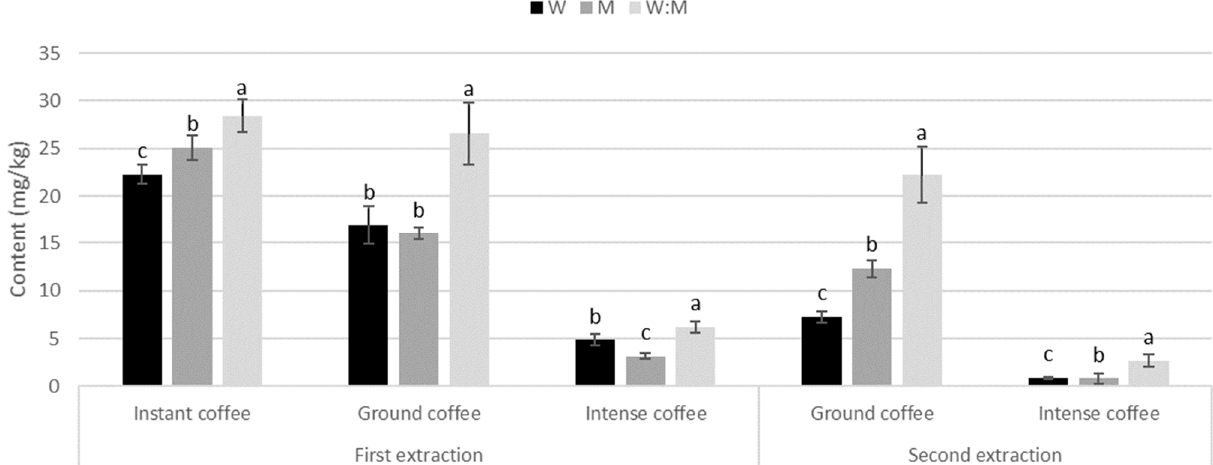
Figure 3. Phenolic acids content (mg/g) during first and second extraction with different solvents in different types of coffees. Different letters indicate statistical significance ( p ≤ 0.05) in phenolic content between solvents.